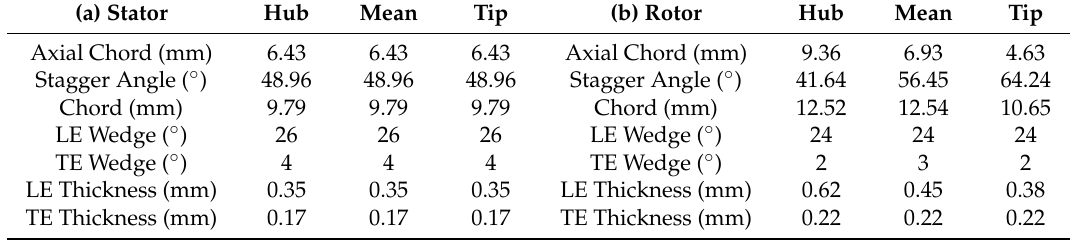
Table 6. Preliminary stator ( a ) and blade profile geometry ( b ) used for bgi generation.